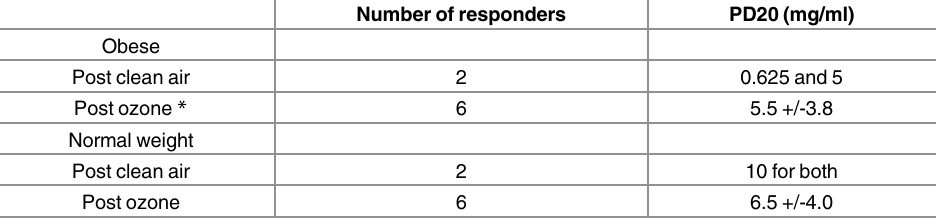
Table 4. Methacholine reactivity. Responder defined by 20% fall in FEV1 at (cid:1) 10mg/ml. PD20 = dose at which FEV1 falls by (cid:3) 20%.